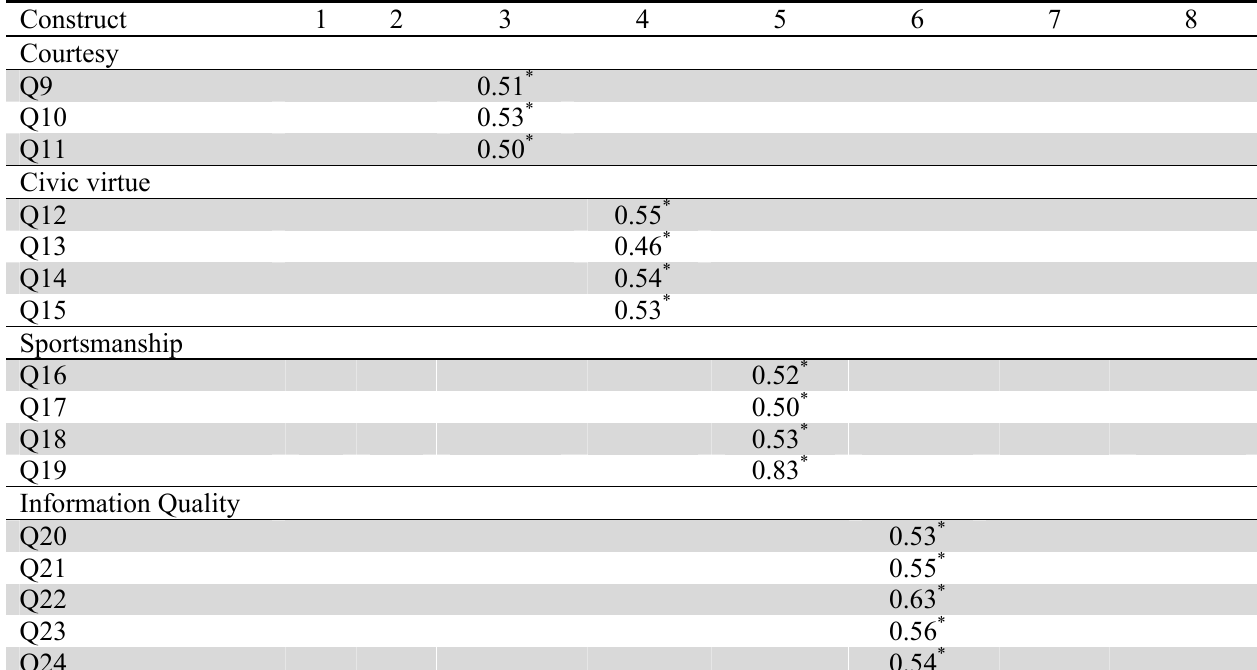
The summary of factor